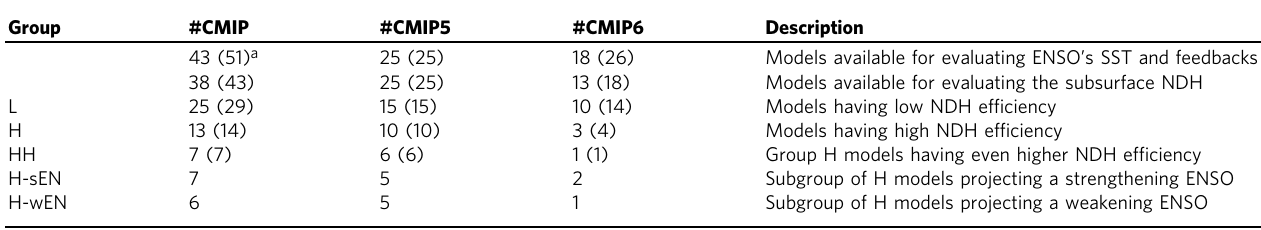
Table 1 Brief summary of CMIP model availability in each group.